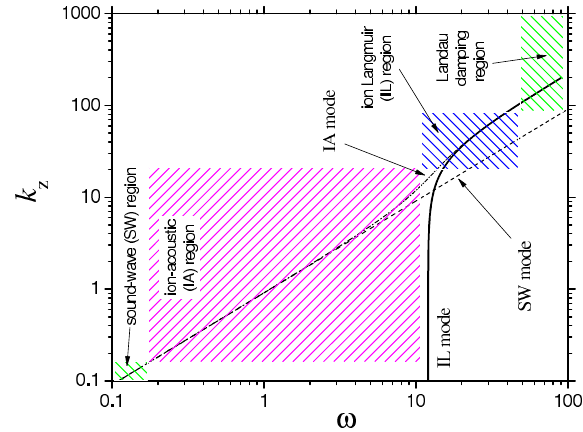
Fig. 4. Background linear oscillation modes in the ω − k plane with ξ T = 5 and ξ ω =